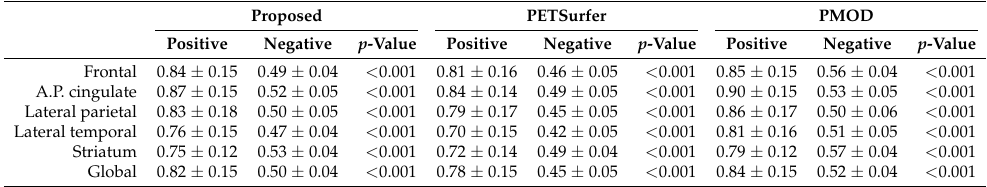
Table 2. Mean SUVR and standard deviation for the three tools (Proposed, PETSurfer, and PMOD) are summarized for 218 participants using flutometamol PET